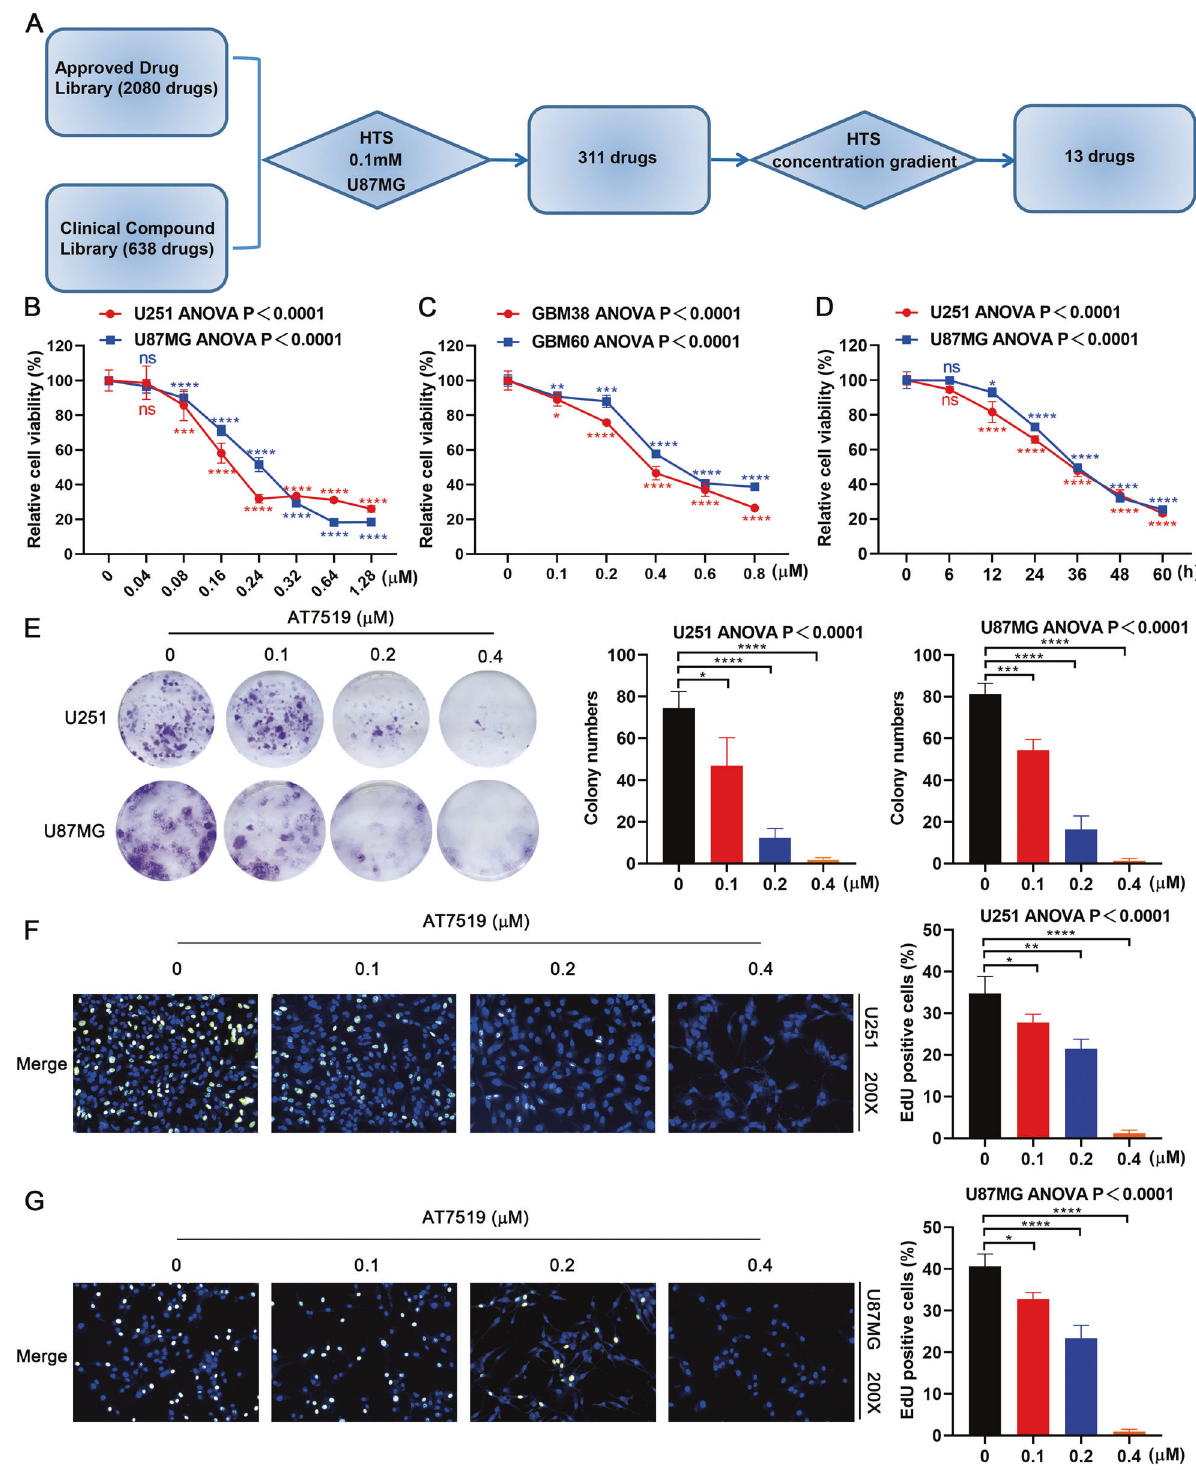
Fig. 1 AT7519 inhibits glioblastoma cell proliferation and viability in vitro. A Process for high-throughput drug screening. B , C U87MG, U251, GBM60, and GBM38 cell viability was determined using a CCK-8 assay after treatment with various concentrations of AT7519. * P < 0.05, *** P < 0.01, *** P < 0.001, and **** P < 0.0001 compared with the control using one-way ANOVA followed by Dunnett ’ s multiple test. D U87MG and U251 cell viability was determined using a CCK-8 assay after treatment with 0.4 µM AT7519 for 6, 12, 24, 48, and 60 h. * P < 0.05, **** P < 0.0001 compared with the control using one-way ANOVA followed by Dunnett ’ s multiple test. E Colony formation assays to verify the effect of AT7519 on glioblastoma cell proliferation. * P < 0.05, *** P < 0.001, and **** P < 0.0001 based on one-way ANOVA followed by Dunnett ’ s multiple test. F , G The level of DNA synthesis of U87MG and U251 cells was determined using an EdU assay after treatment with increasing concentrations of AT7519. The nuclei were stained with Hoechst (blue), and the proliferating cells were stained with EdU (yellow). * P < 0.05, *** P < 0.001 and **** P < 0.0001 based on one-way ANOVA followed by Dunnett ’ s multiple test. The results are presented as the mean ± SD from three independent experiments. Cell Death and Disease (2023)